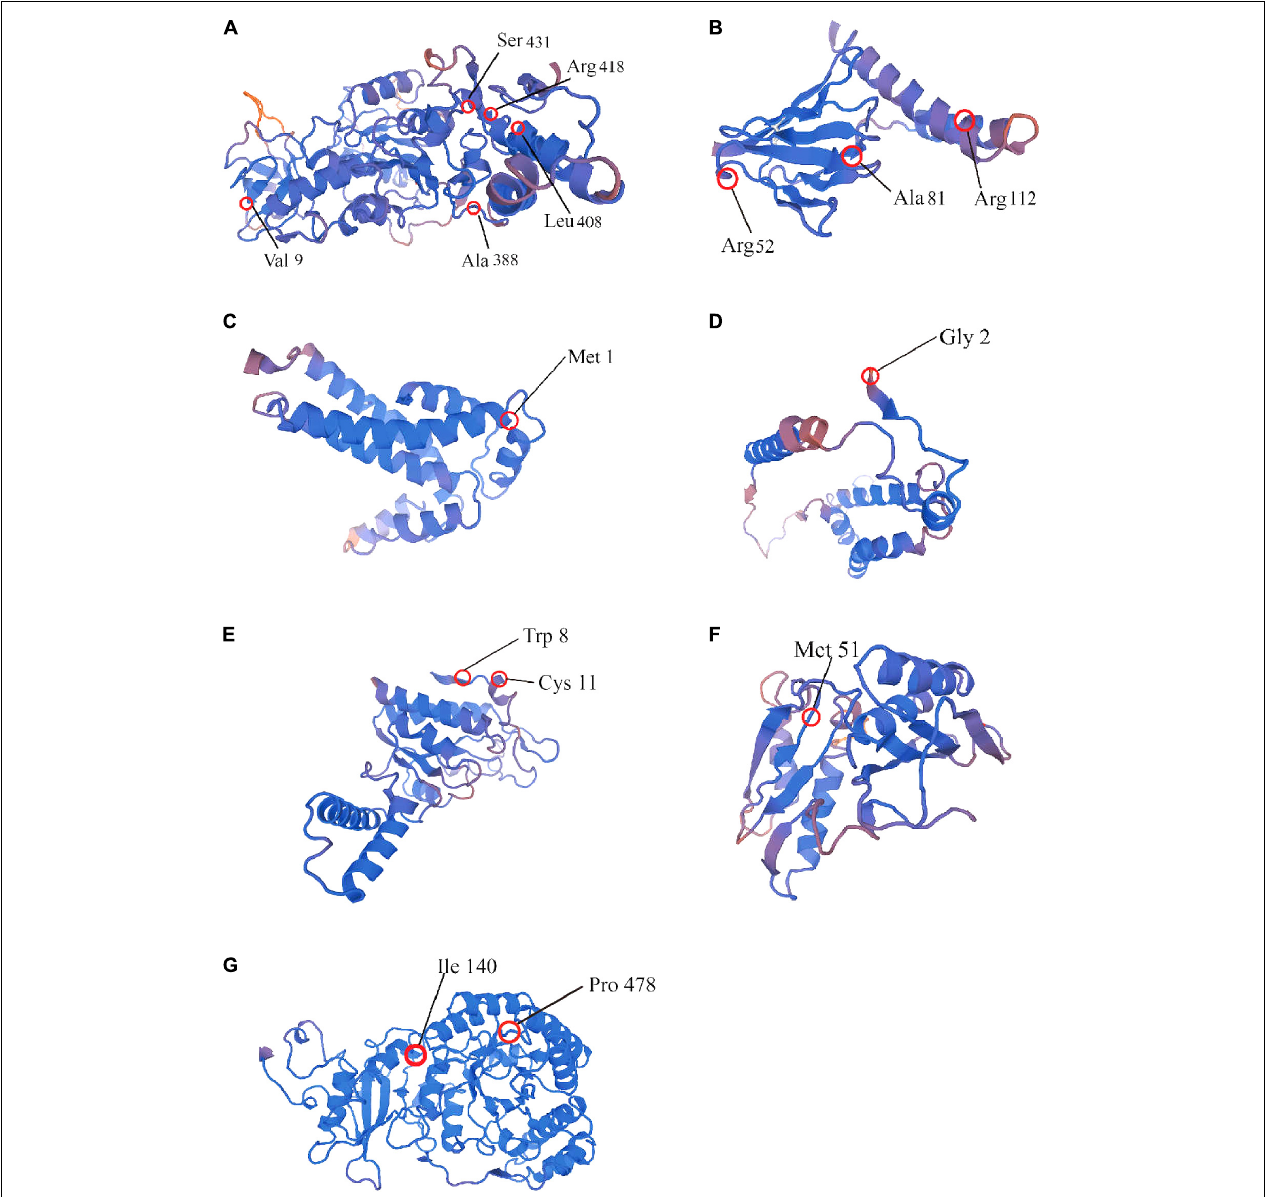
FIGURE 5 | Reference three-dimensional structures of seven positively selected genes: (A) atpB ; (B) atpE ; (C) petB ; (D) petD ; (E) rps2 ; (F) rps3 ; and (G) rbcL